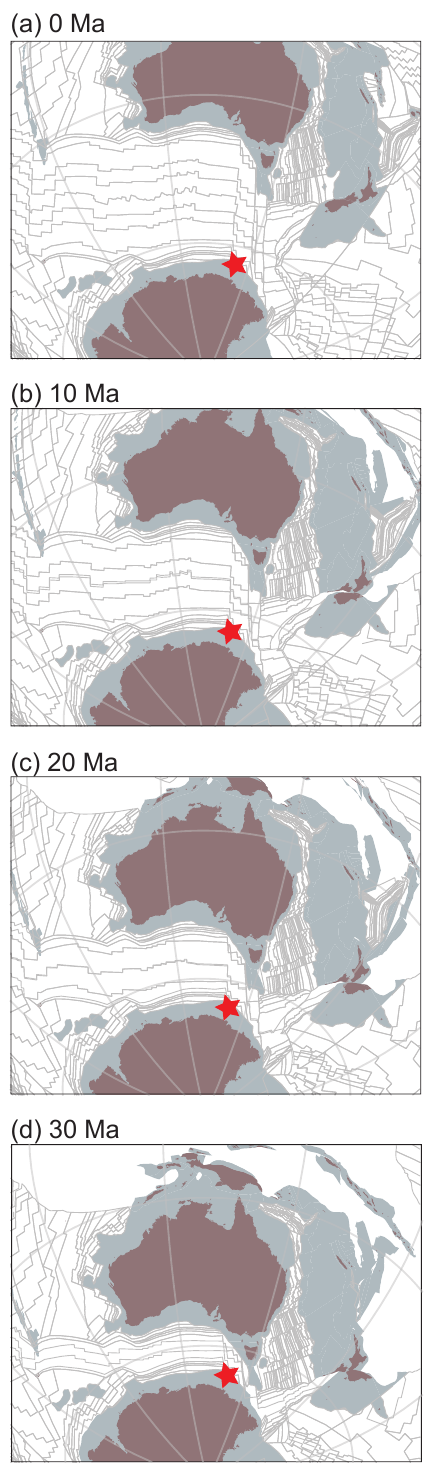
Figure 1. Paleogeography of the southwestern Pacific Ocean and position of IODP Site U1356 (red star) at (a) 0Ma, (b) 10Ma, (c) 20Ma and (d) 30Ma. Figures are modified after Bijl et al. (2018a). Reconstructions were adapted from G plates, with the plate circuit from Seton et al. (2012) and absolute plate positions of Torsvik et al.